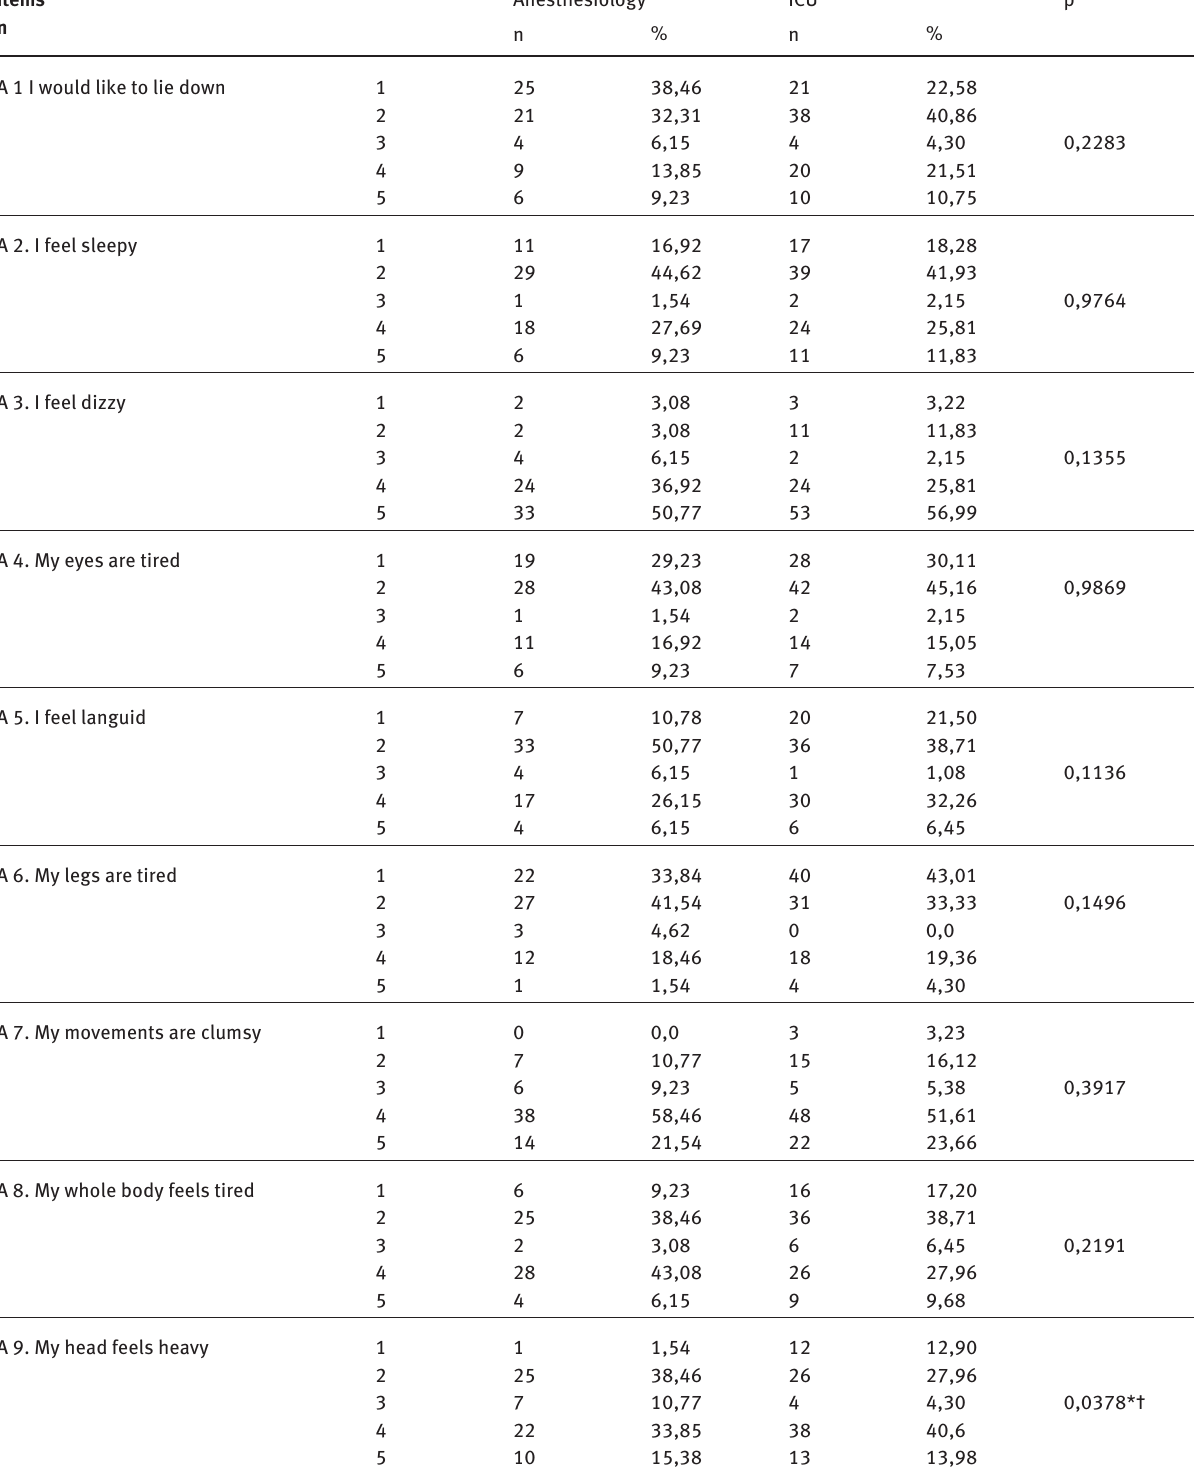
Table 2: The neurophysiologic fatigue symptoms